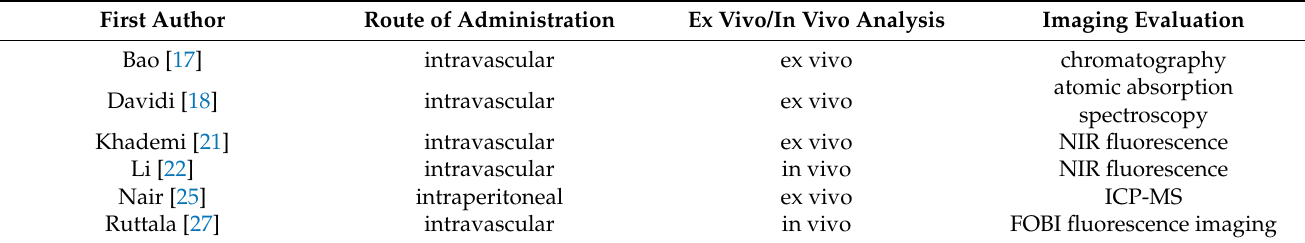
Table 4. Biodistribution of